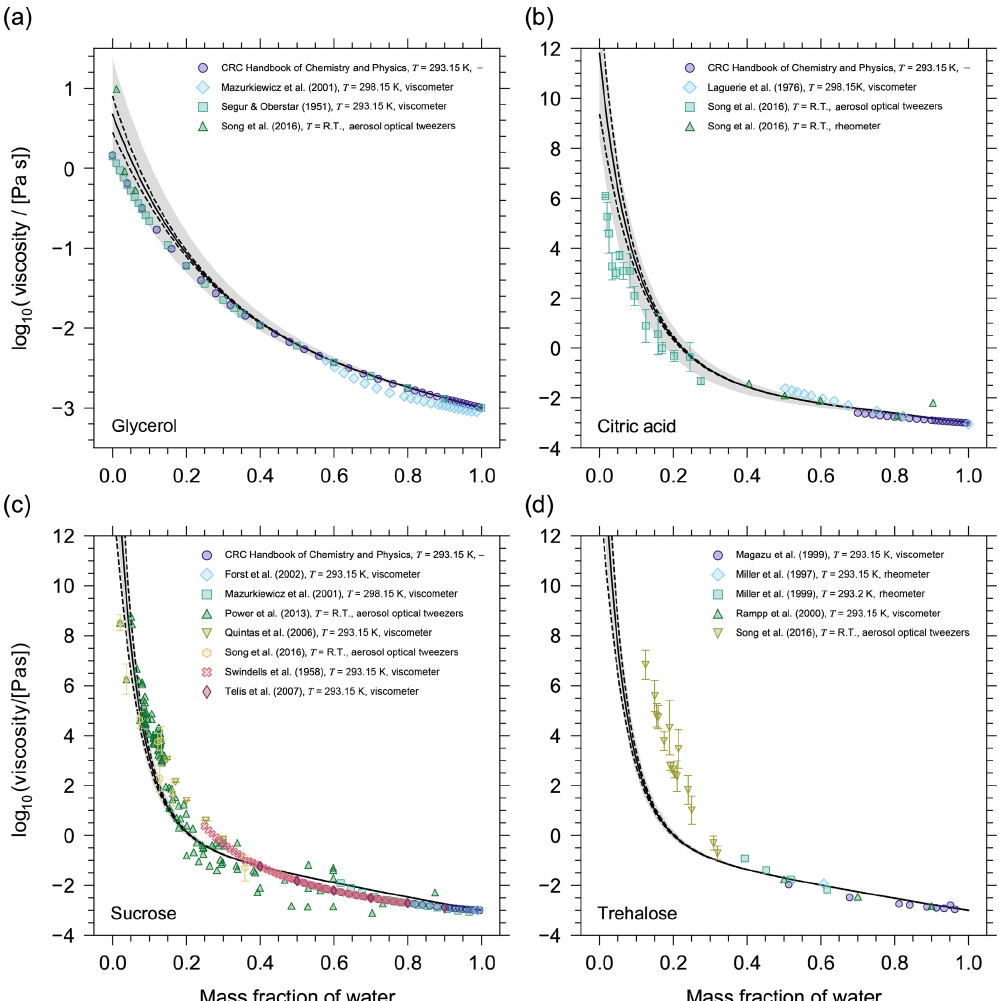
Figure 5. AIOMFAC-VISC mixture viscosity predictions as a function of mass fraction of water at 293.15K for (a) glycerol, (b) citric acid, (c) sucrose, and (d) trehalose. The solid black line is the AIOMFAC-VISC mixture viscosity prediction. The dashed black lines show the AIOMFAC-VISC sensitivity. The model sensitivity is assessed by calculating the response of the model to a small change in mixture composition (see Sect. 2.4). The grey shaded area denotes a 5% uncertainty in the prediction of T g . Markers show experimental data. Error bars have been omitted when the length of the error bar does not exceed the width of the